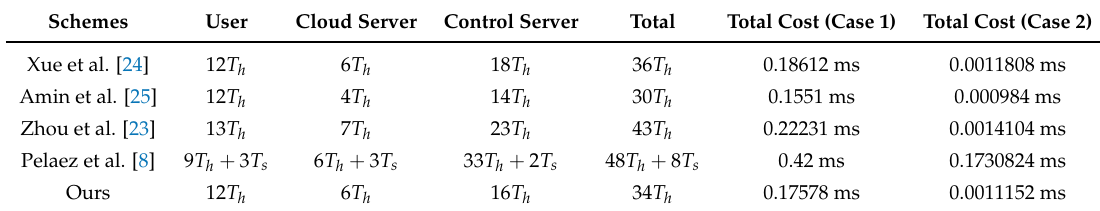
Table 3. A comparative summary: computation